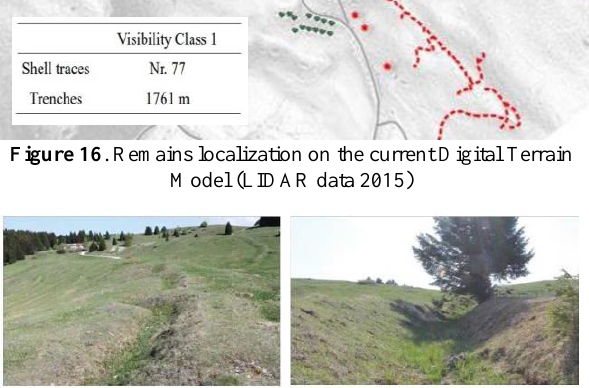
Figure 17 . Identified remains: current state of conservation.